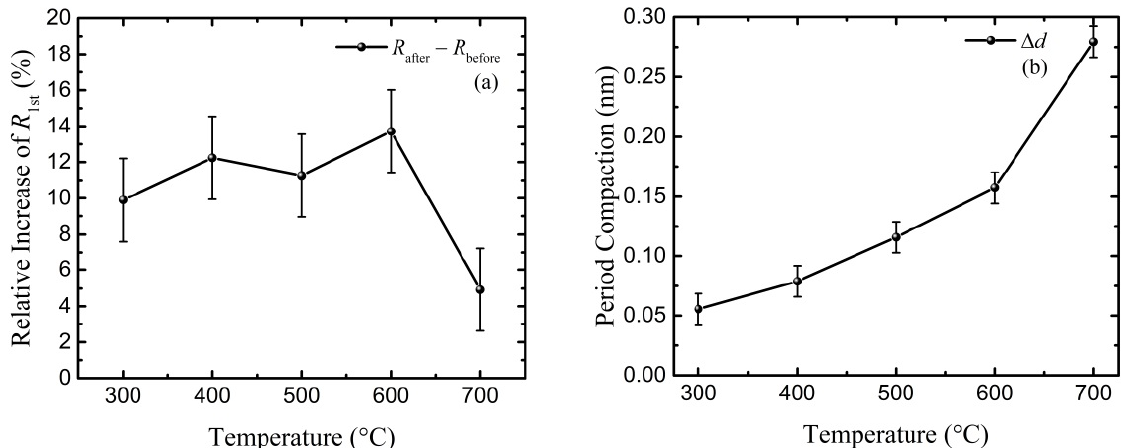
Figure 2. Relative changes of the first-order reflectivity ( a ) and period ( ∆ d ) ( b ) of the Ru/C multilayers after different annealing temperatures.